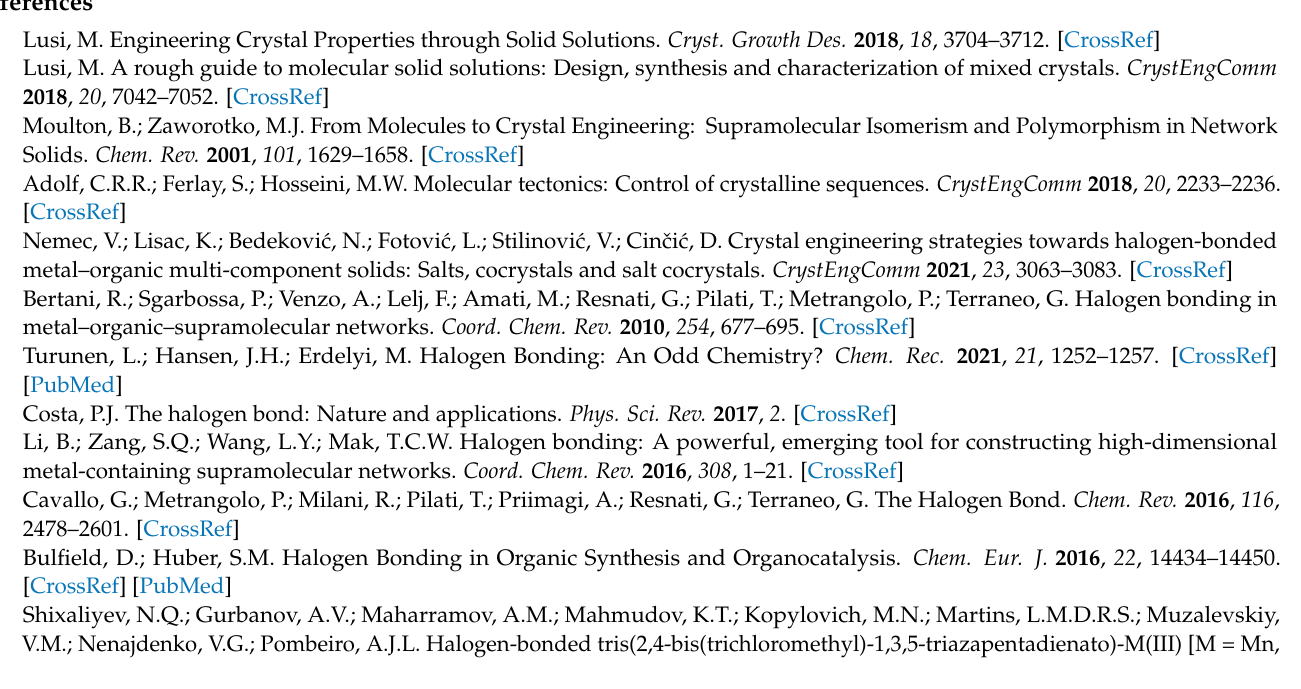
Figure S4. 1D chains of 1 – 3 complex molecules bound by C–H ··· Cl–M hydrogen bonds. Figure S5. Hirshfeld surfaces for 1–3 . Figure S6. Contributions of various intermolecular contacts to the molecular Hirshfeld surfaces of 1–3 complex molecules. Figure S7. HOMO and LUMO orbital diagrams of 1–3 obtained by